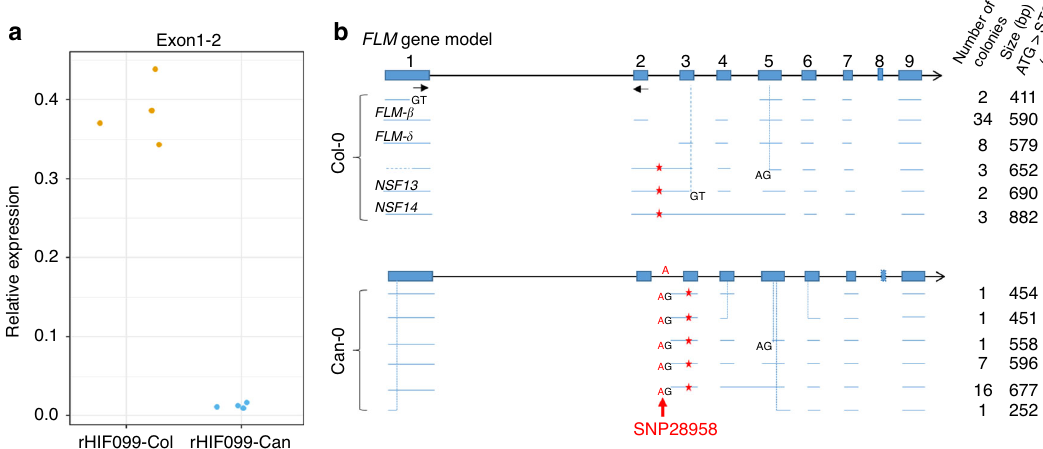
Fig. 2 FLM transcripts characterization in Can-0 and Col-0. a Transcript accumulation was measured by qRT-PCR in rosette leaves grown on the Phenoscope from rHIF099 homozygous for the Can or the Col allele, using primers located in exon1 and exon2 of FLM (qFLM-F3 + qFLM-R3b), represented by black arrows in b . Each dot represents the mean of a technical duplicate from an individual plant. b PCR products of the FLM coding region of Col-0 and Can-0 (from the start to the stop codons) were used for subcloning and the colonies obtained were screened by PCR to estimate the size of many subcloned fragments. Plasmids of one or two colonies carrying a PCR product with a distinct band size were sent for Sanger sequencing. This provided the sequences illustrated here with the horizontal blue lines. An estimate of the frequency of each isoform sequenced is given according to the size of the PCR product obtained during the colony screening. The vertical dashed lines specify a discrepancy between the annotation and the isoform sequenced. New donor (GT) and acceptor (AG) splice site are depicted when present. Red stars represent premature stop codon. In Col-0, FLM- β as well as variants previously identi fi ed 38,39 are mentioned ( FLM- δ , NSF13 , and NSF14 ). The candidate polymorphism responsible for the splicing shift observed in most of the FLM-Can transcripts is depicted in red ( “ SNP28958 ” ). Source data underlying Fig. 2a are provided as a Source Data fi